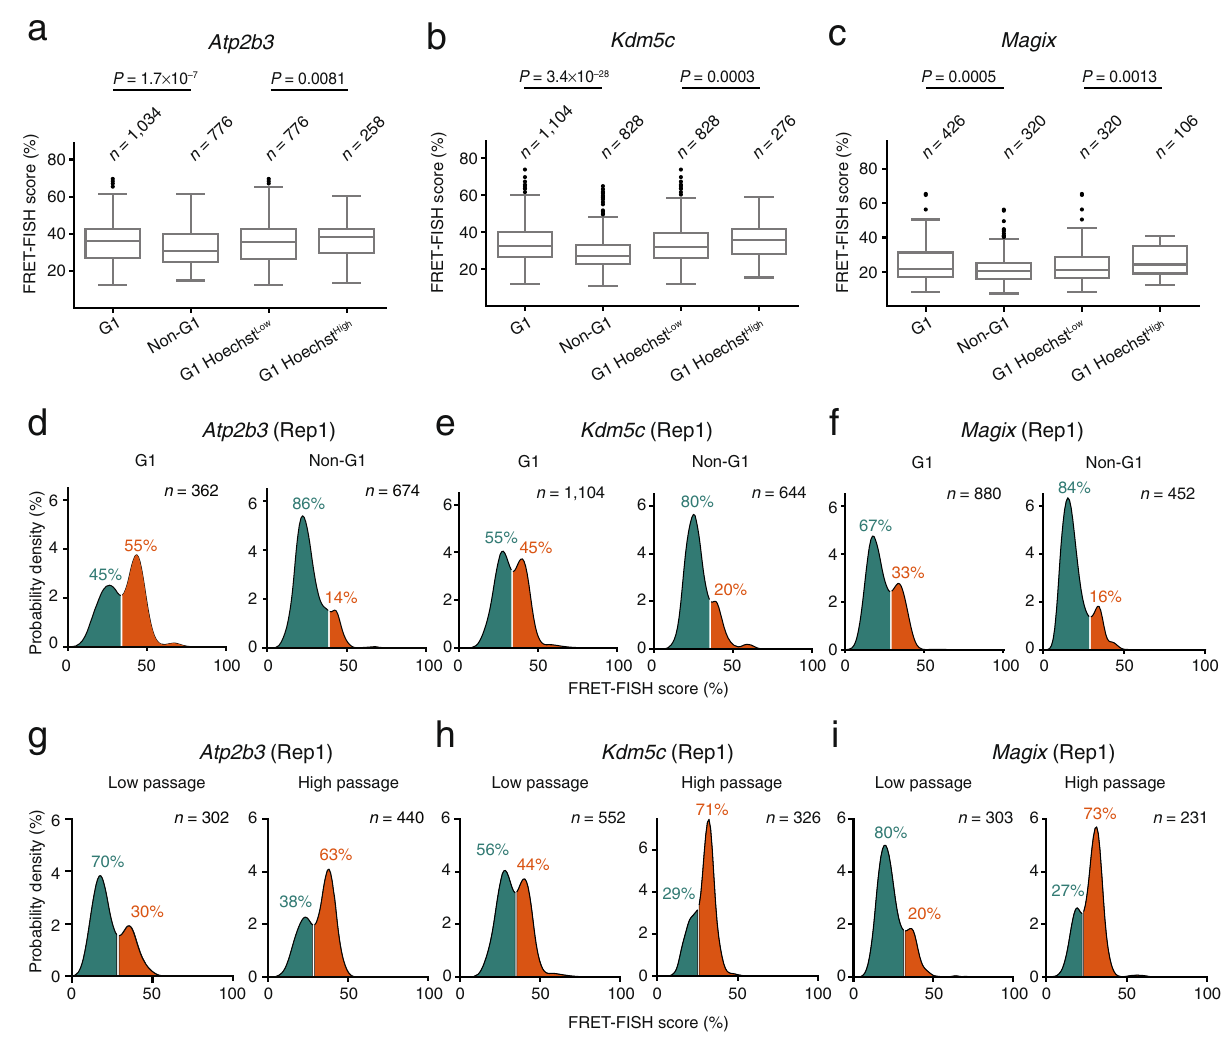
Fig. 4 | Local chromatin compaction is in fl uenced by the cell cycle phase and cellpassaging.a – c FRET-FISHscoredistributionsindifferentcellcyclephases,for three of the six loci probed by FRET-FISH on chrX in female mouse embryonic fi broblasts (MEFs). Measurements from three replicate experiments pooled toge- ther are shown. G1 Hoechst High and G1 Hoechst Low indicate cells in G1 phase with values of Hoechst 33342 nuclear fl uorescence intensity in the top and bottom quartile of the corresponding intensity distribution, respectively. Boxplots extend from the 25th to the 75th percentile, horizontal bars represent the median, and whiskers extend from – 1.5×IQR to +1.5×IQR from the closest quartile, where IQR is the inter-quartile range. Black dots, outliers. In each boxplot, the minimum and maximumarede fi ned,respectively,bytheuppermostandlowermostoutlierdotor